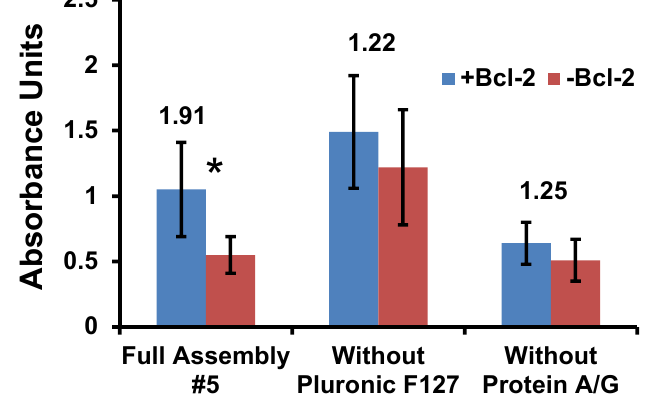
Figure 3. Bcl-2 detection on variations of engineered surface #5 was quantified by ELISA. Mean values are presented with error bars representing SEM (*P < 0.05, n = 4). /A ) are displayed above the bar Signal-to-noise ratios (A +Bcl-2 -Bcl-2